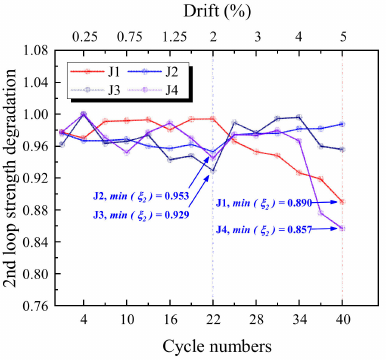
Figure 14. 2nd loop strength degradation